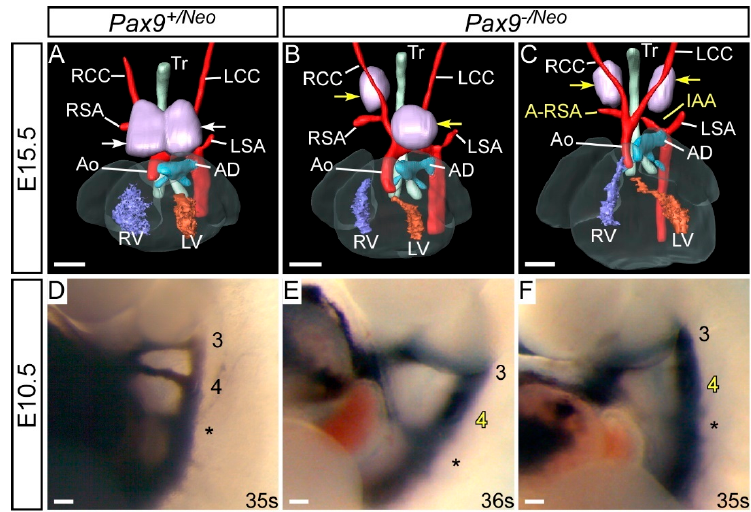
Figure 4. Developmental defects in Pax9 -hypomorphic mouse embryos. Pax9 +/Neo control ( A , D ) and Pax9 –/Neo mutant ( B , C , E , H ) mouse embryos were collected and analysed for cardiovascular defects using magnetic resonance imaging at E15.5 ( A – C ) and intracardiac ink injections at E10.5 ( D – F ). ( A ) Control embryo with normal cardiovascular anatomy and thymus lobes (white arrows). Pax9 –/Neo mutant embryos have normal arch arteries ( B ) or display fourth pharyngeal arch artery derived defects such as aberrant right subclavian artery and interruption of the aortic arch ( C ). The thymus lobes are frequently abnormal (yellow arrows; ( B , C )). ( D ) The third (3), fourth (4) and ultimate (*) pharyngeal arch arteries are of equivalent size and patent to ink in control embryos. ( E , F ) In stage-matched Pax9 –/Neo mutant embryos the fourth arch arteries are frequently absent. Somite numbers (s) are indicated. Abbreviations: AD, arterial duct; Ao, aorta; A-RSA, aberrant right subclavian ar- tery; IAA, interrupted aortic arch; RCC, LCC, right/left common carotid artery; RSA, LSA, right/left subclavian artery; RV, LV, right/left ventricle; Tr, trachea. Scale bar: 500 mm in ( A – C ), 100 mm in ( D – F ).